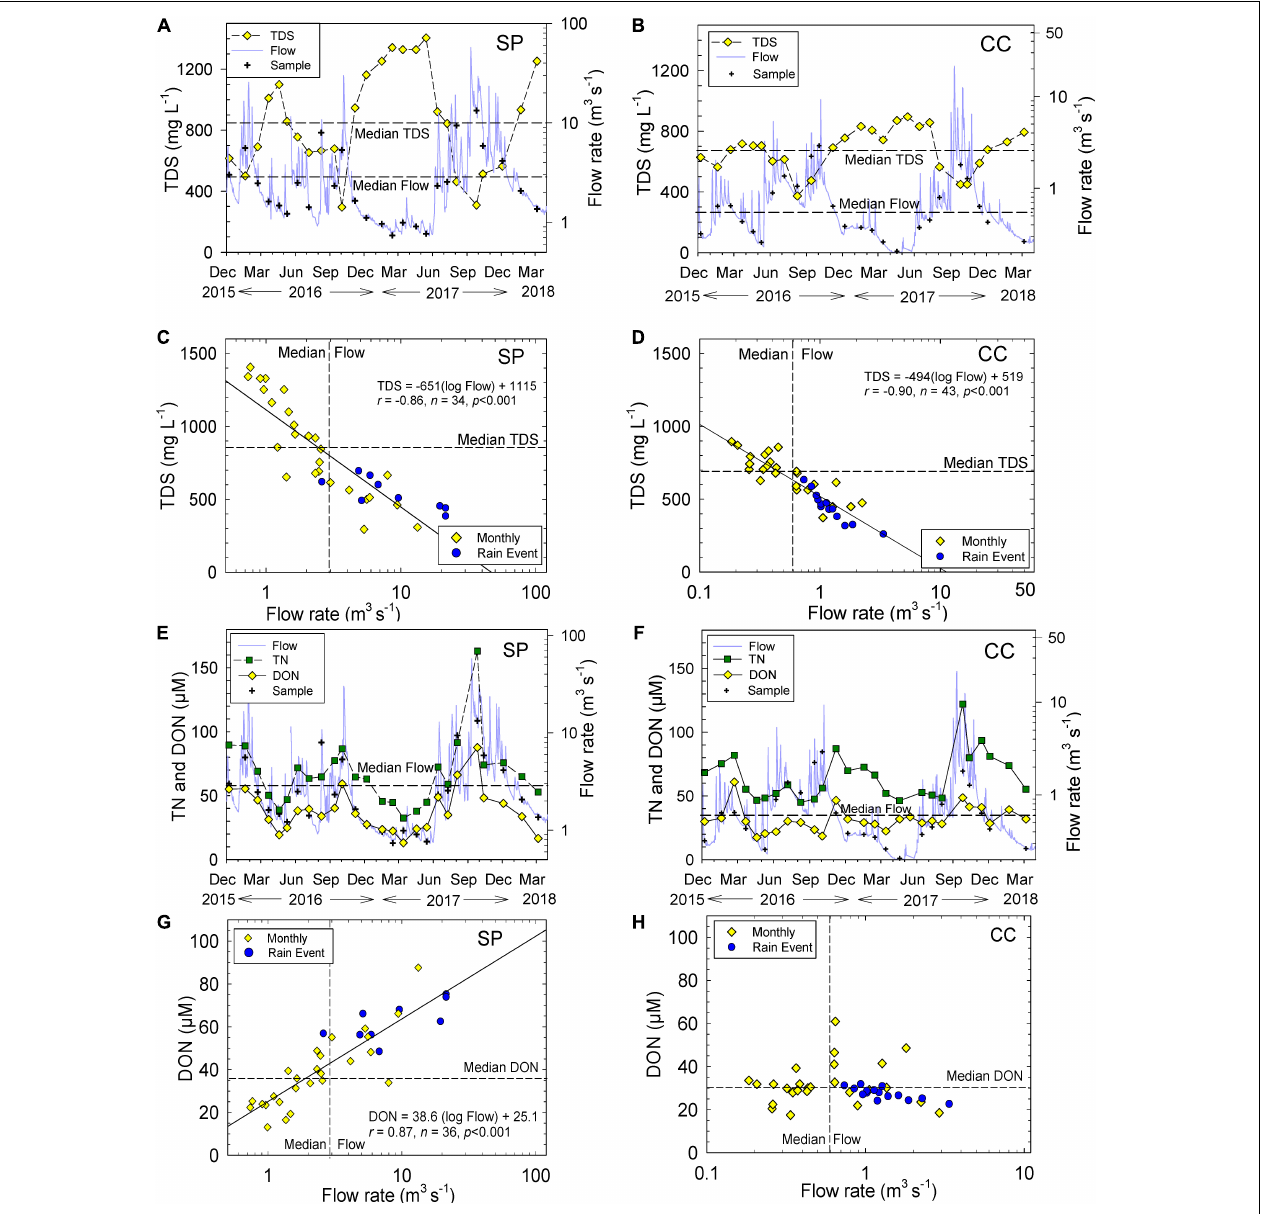
FIGURE 3 | Total dissolved solids (TDS) and flow rate for monthly samples at (A) South Prong Saint Sebastian River (SP) and (B) Crane Creek (CC). TDS versus flow rate for (C) SP and (D) CC. Total nitrogen (TN), dissolved organic nitrogen (DON) and flow rate for (E) SP and (F) CC. DON versus flow rate for (G) SP and (H) CC. Equations and lines on (C,D,G) from linear regression, with correlation coefficient ( r ), number of samples ( n ) and p statistic. Median concentrations are for monthly